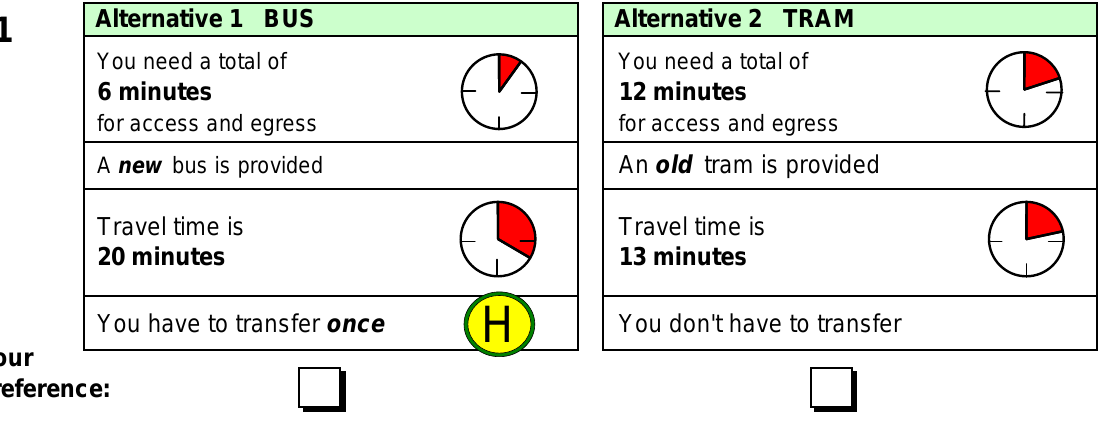
Figure 3. Example of the within-mode stated preference